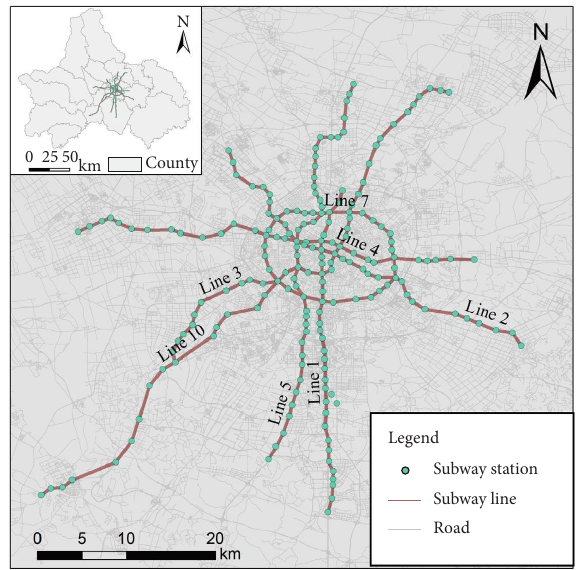
Figure 1: Study areas and the subway system in